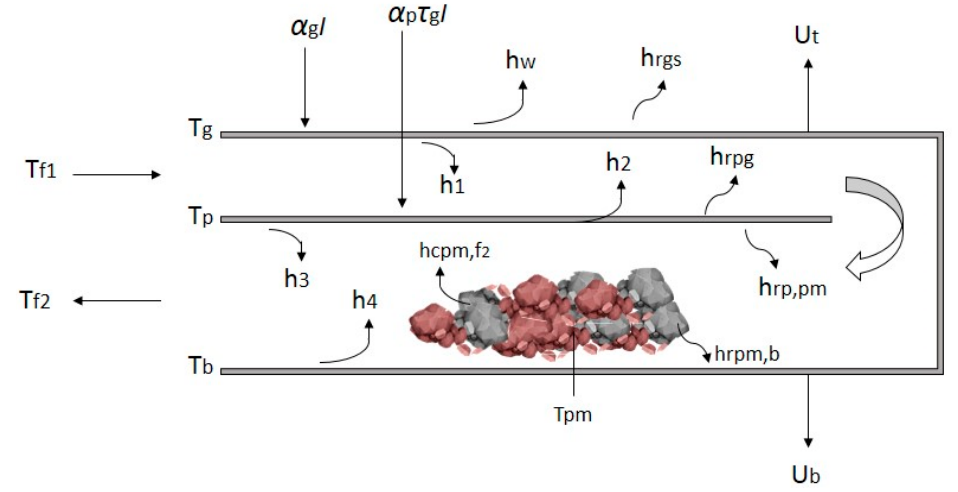
Figure 4. Schematic of heat transfer coefficient in DPSAH with lava rock.